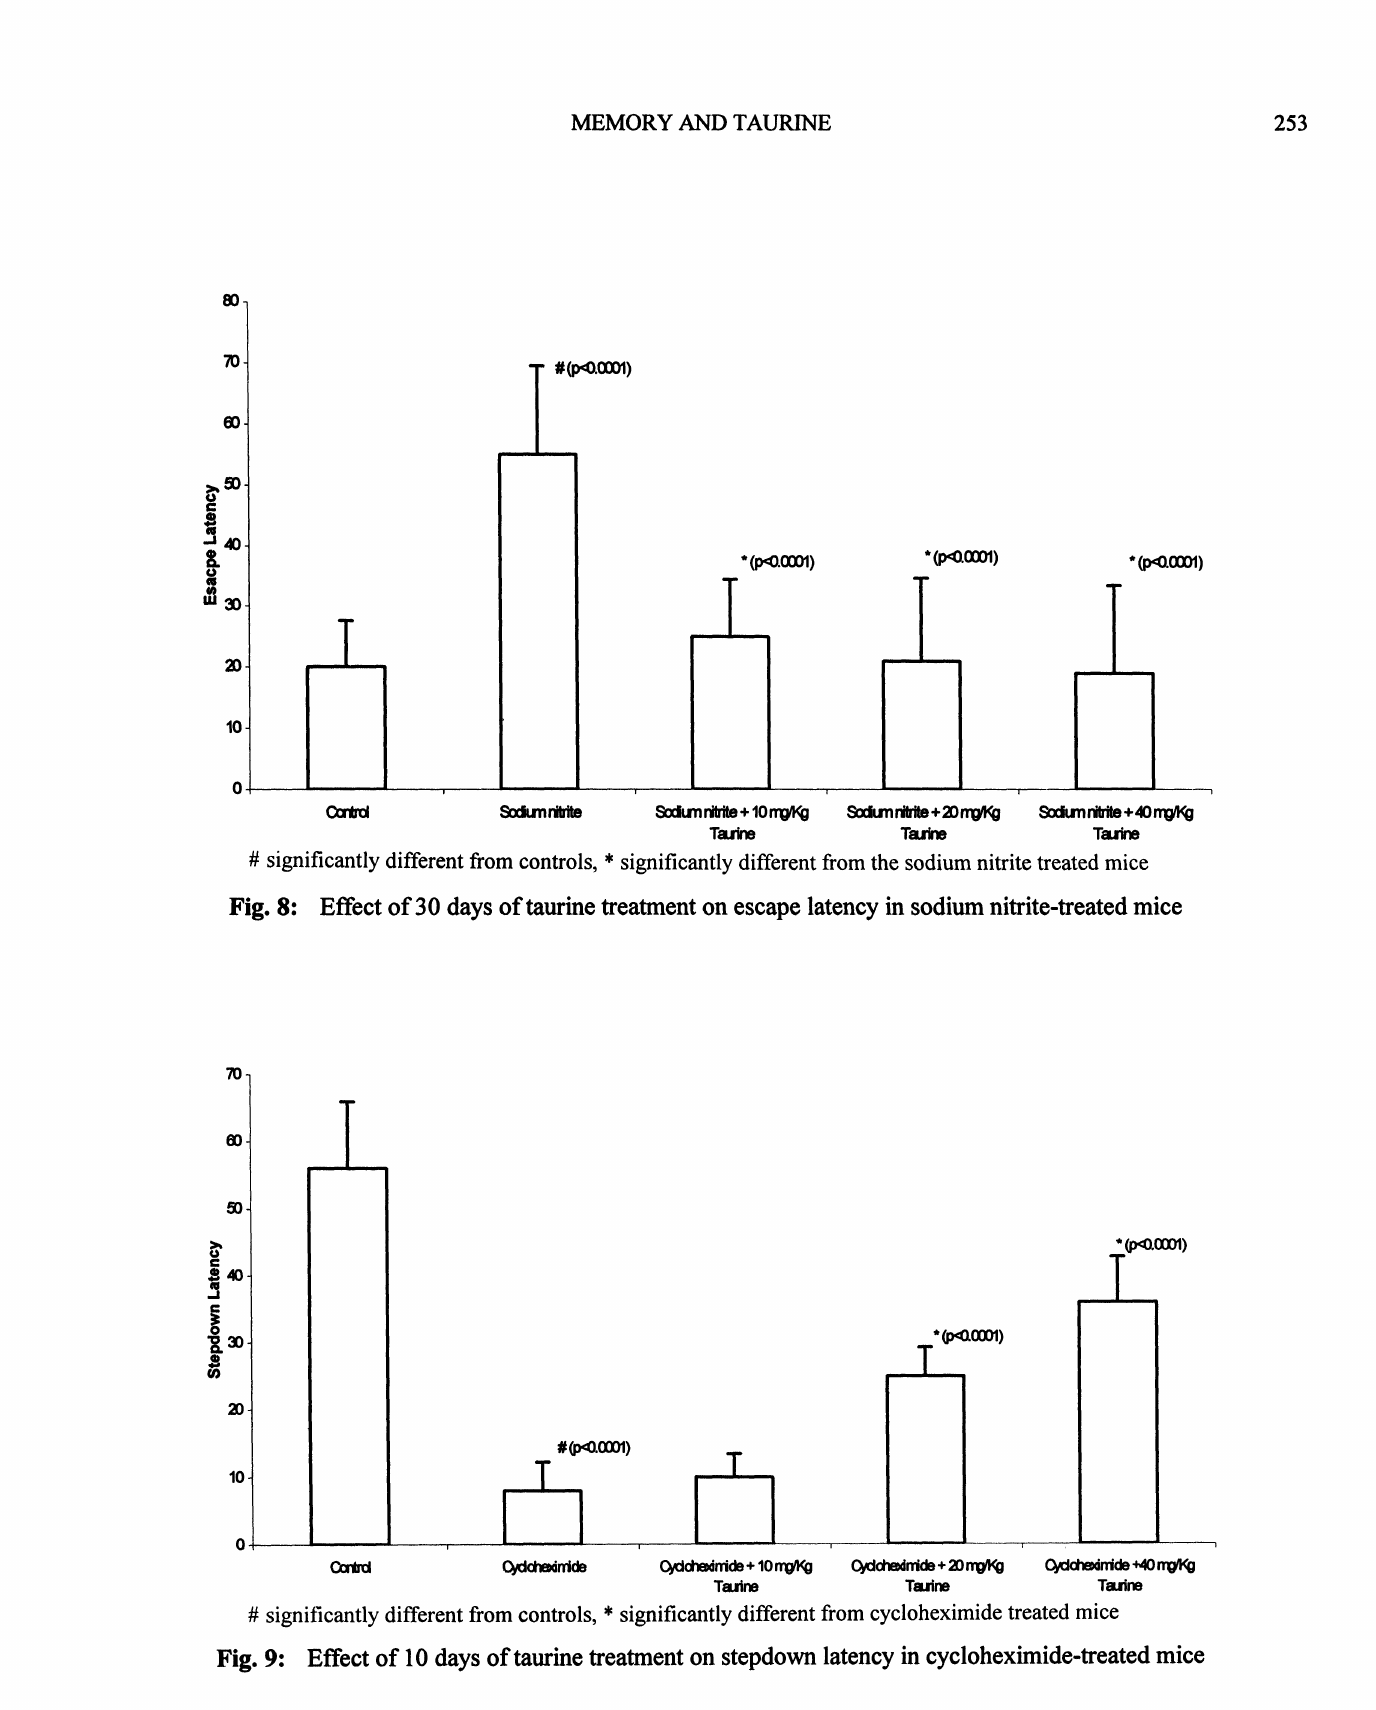
Fig. 9: Effect of 10 days of taurine treatment on stepdown latency in cycloheximide-treated